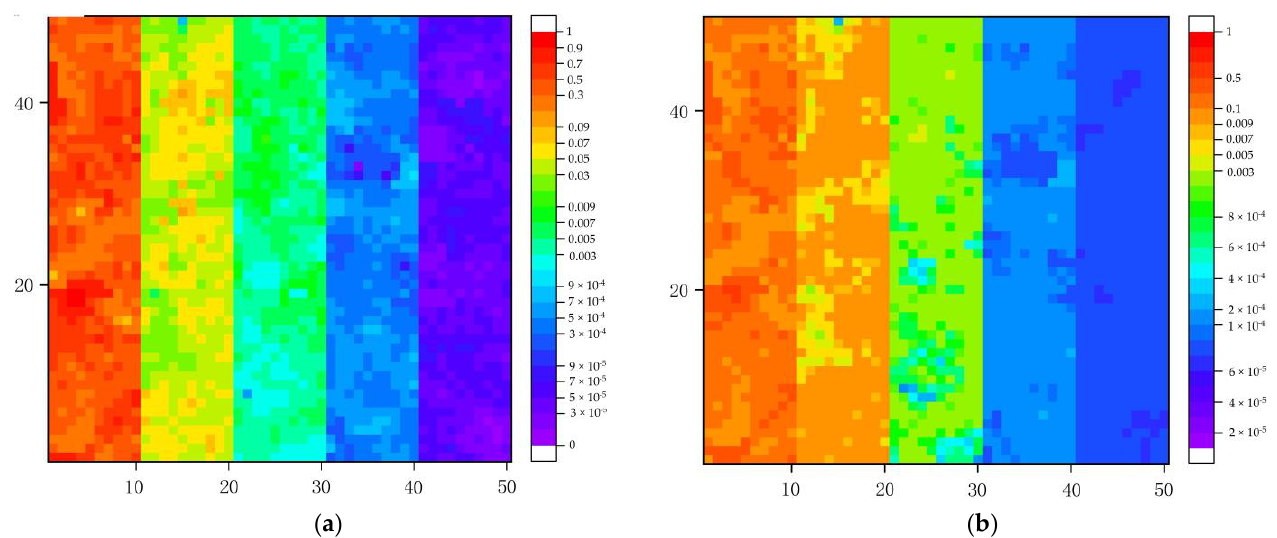
Figure 6. Simulated oil spill distribution map.